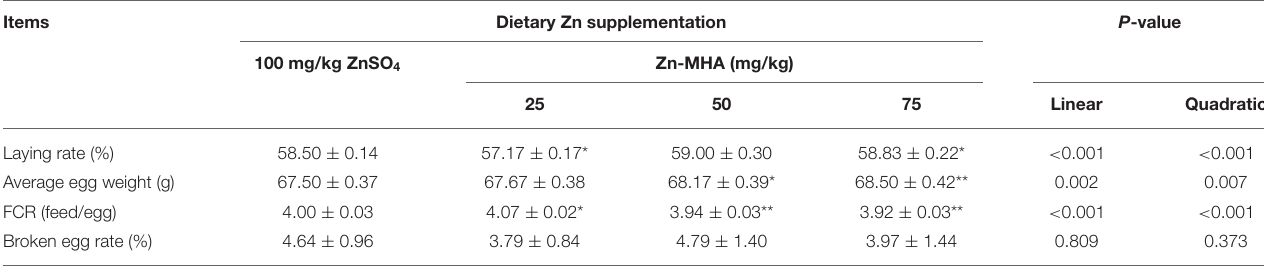
TABLE 3 | Effects of dietary Zn-MHA supplementation on laying performance of broiler breeders a . Items